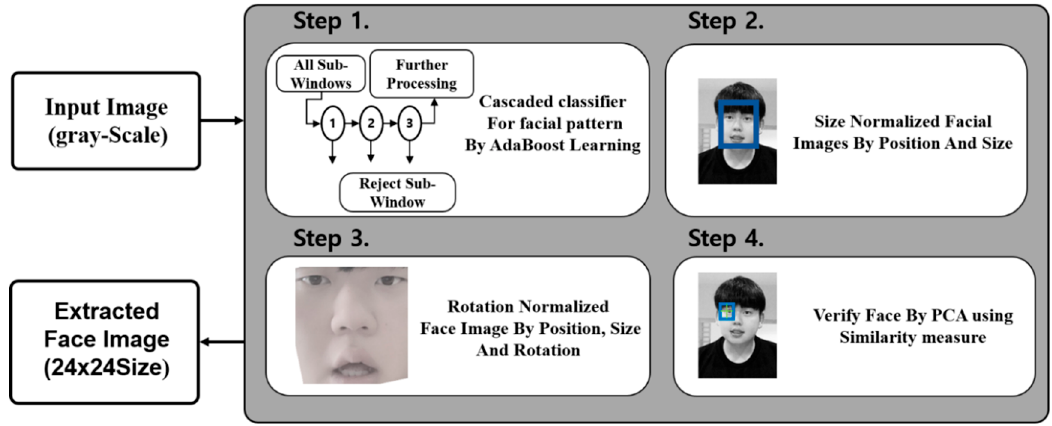
Figure 6. The whole facial recognition and emotion analysis process. * The figure included in this image is the author, who agreed to provide the figure. image is the author, who agreed to provide the